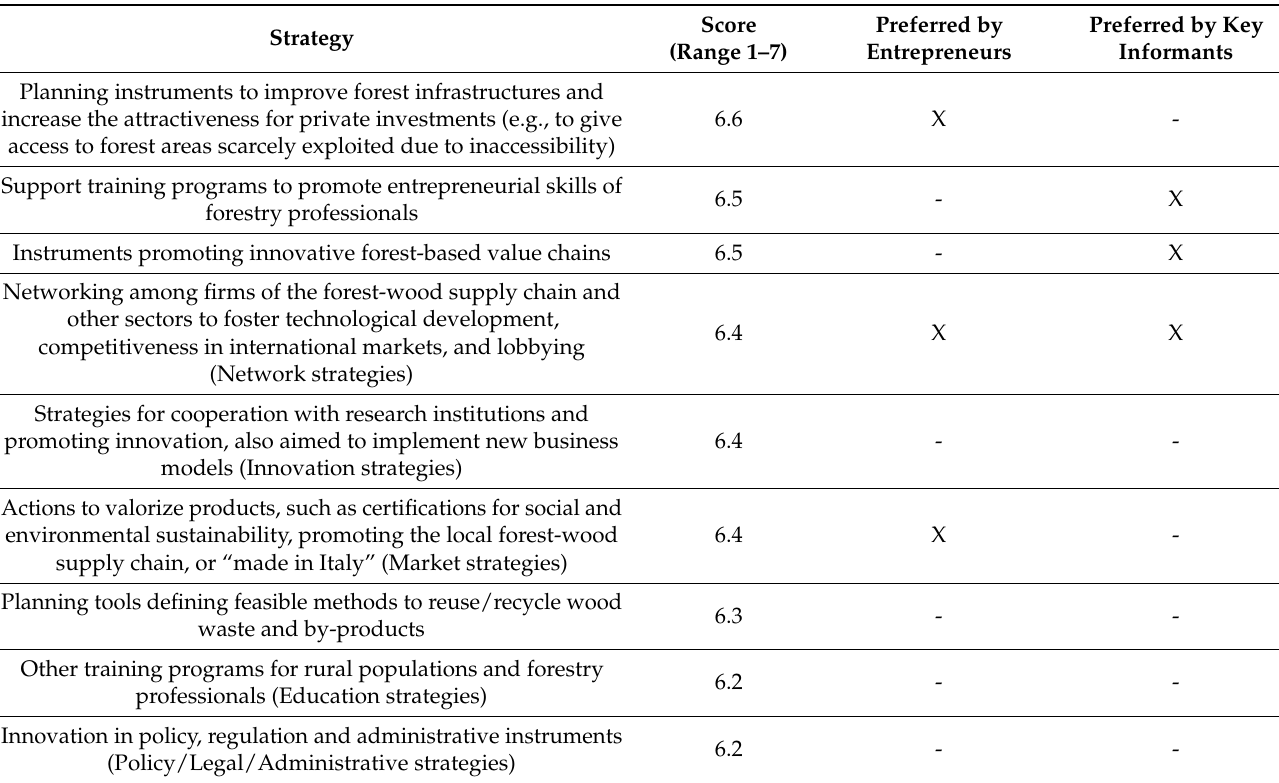
Table 1. Rating of strategies for CBE transition.